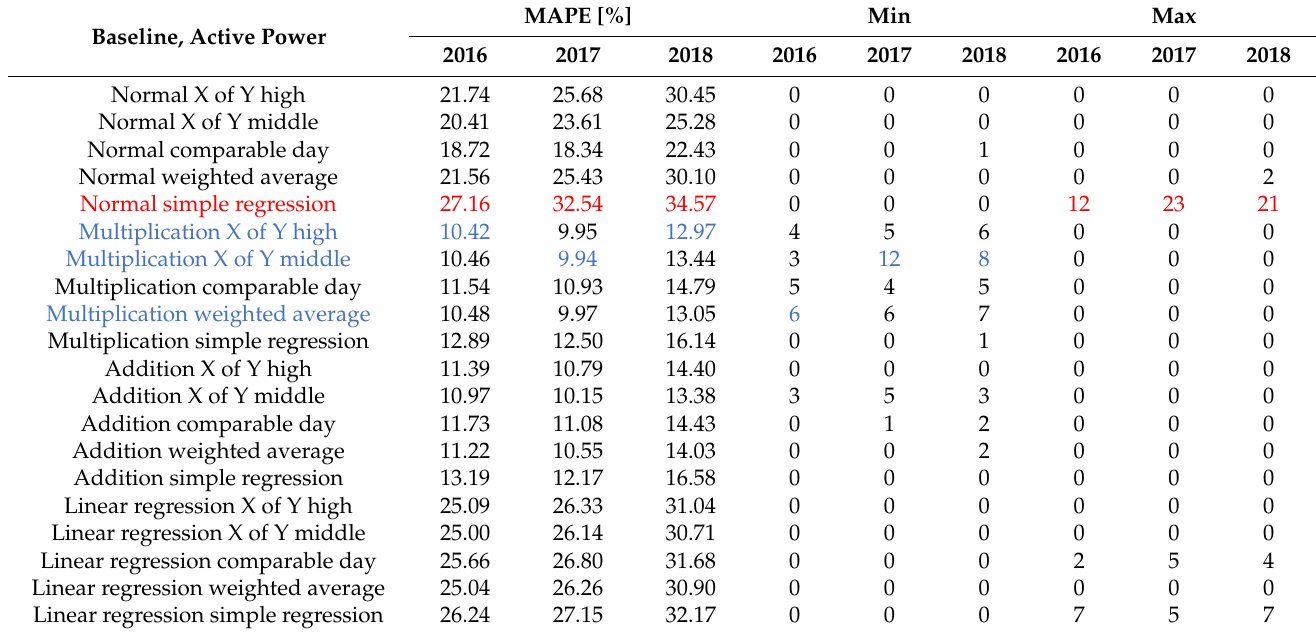
Table 3. Baseline, active power, MAPE (highlighted in red are the worst results, highlighted in blue are the best results). Baseline, Active